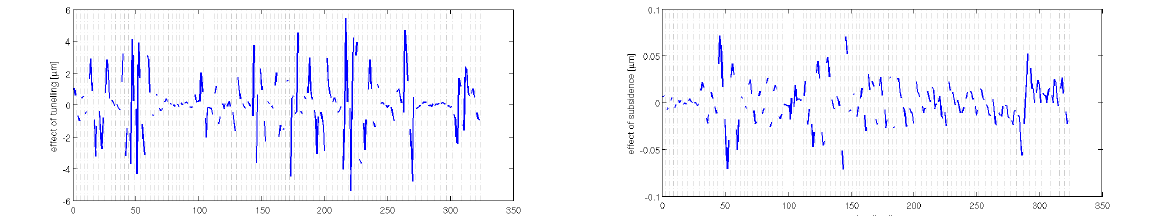
Figure 6. Effect of the level surface deformations on the levelling measurements due to the subsidence. The horizontal axis counts the number of benchmarks, grouped according to the 80 levelling lines, separated by grey vertical dashed lines.